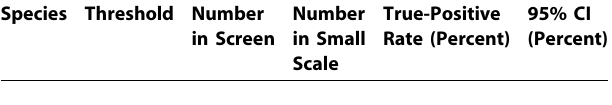
Number in Screen in Small